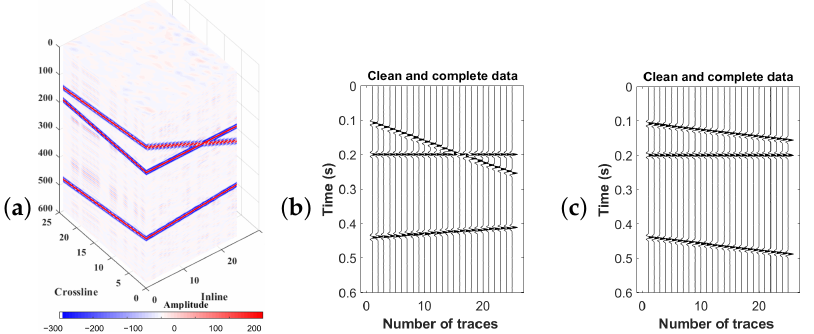
Figure 1. ( a ) Cube of 3-D data having three linear events. Slice of data in ( b ) inline direction, ( c ) cross-line direction.